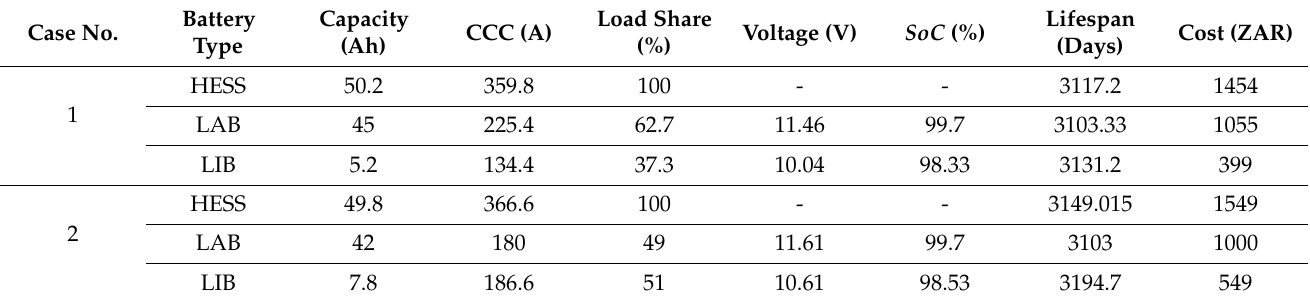
Table 9. The summary of the results for the proposed HESS in different operating